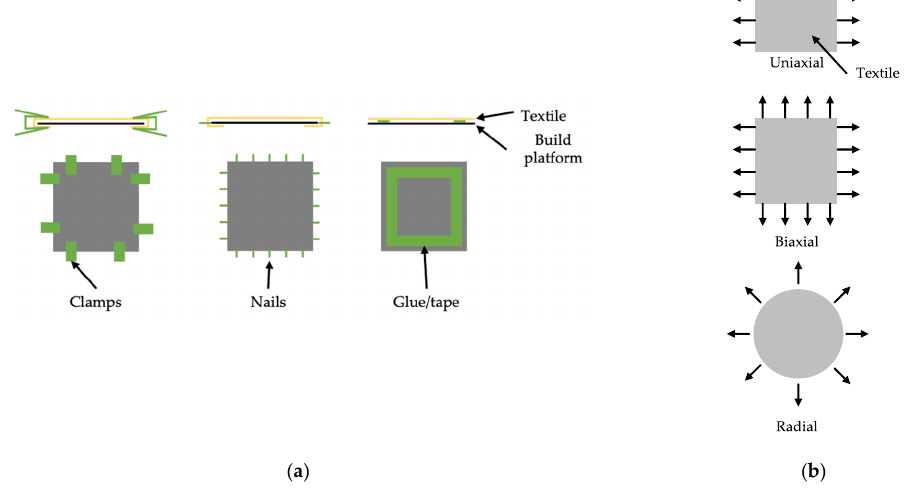
Figure 4. Pre-stressing the textile: ( a ) systems used are clamps, nails, glue and tape; ( b ) three main pre-stressing directions: uniaxial, biaxial and radial.